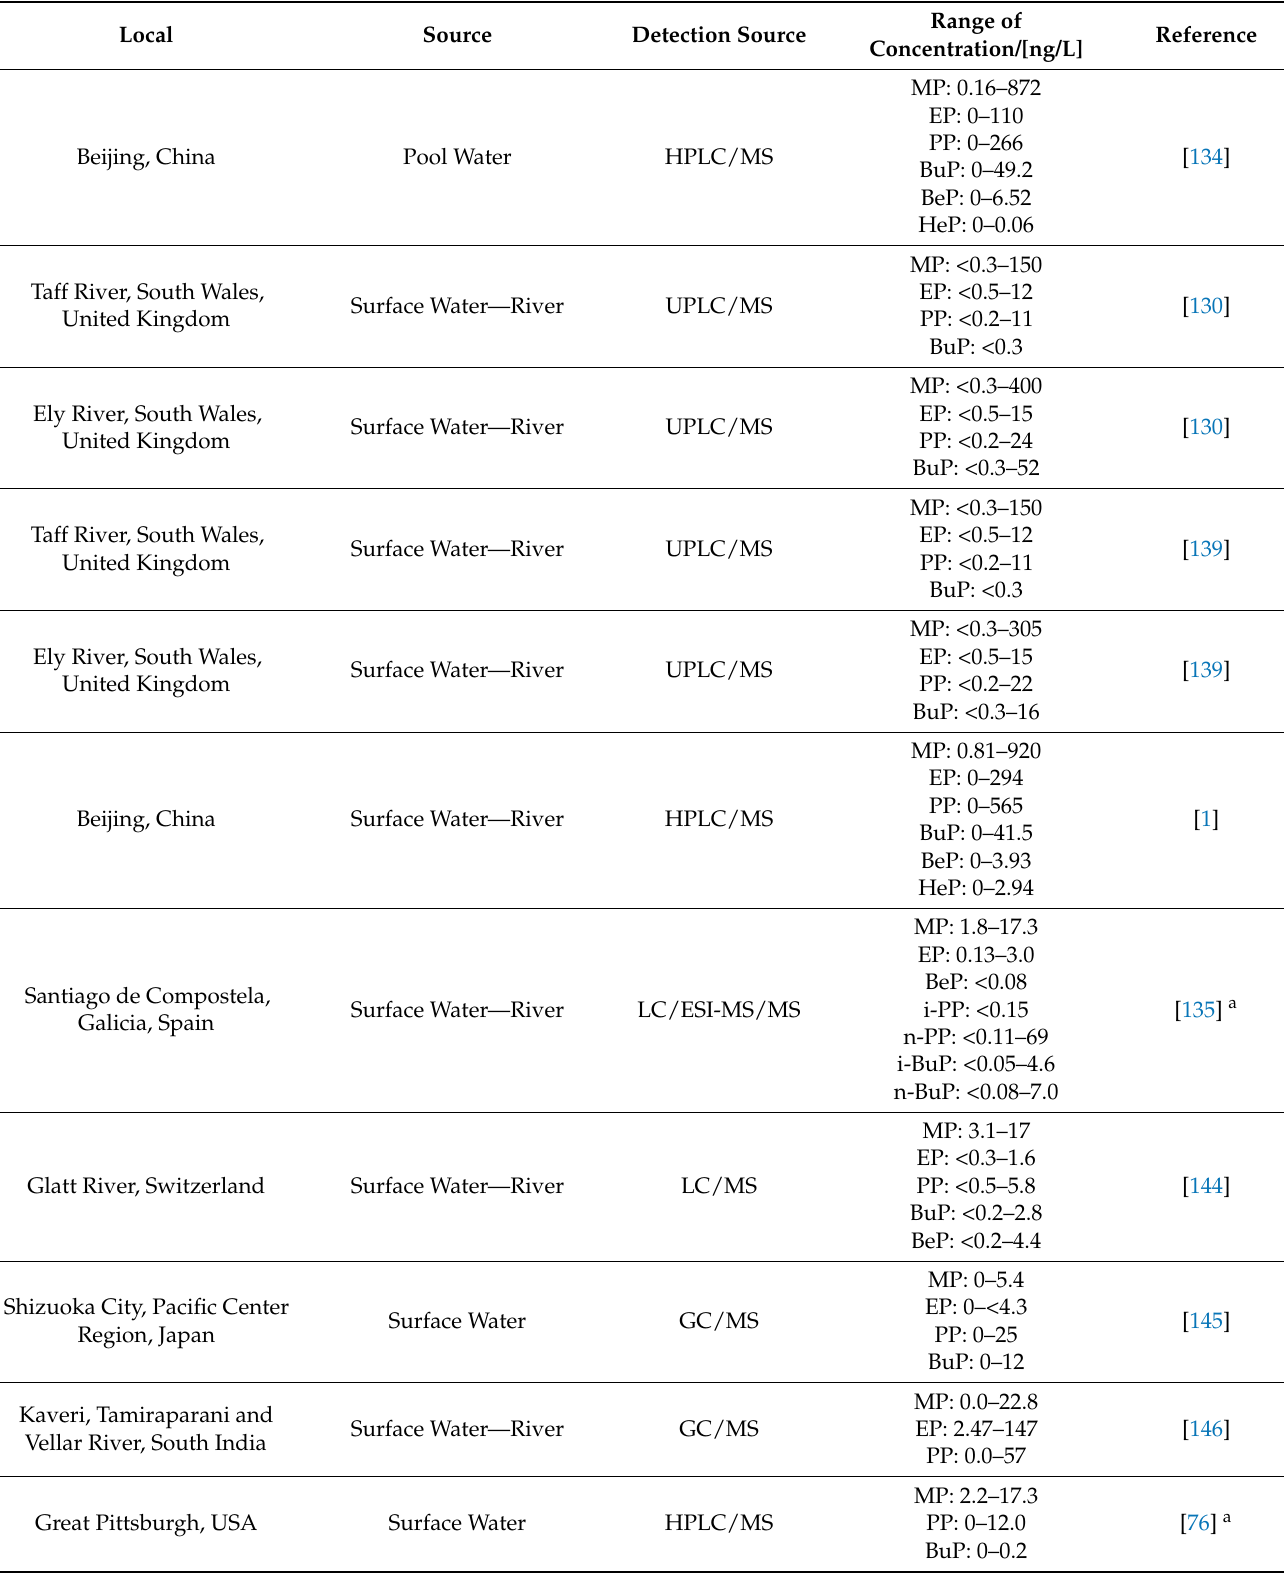
Table 5. Paraben detected in several water